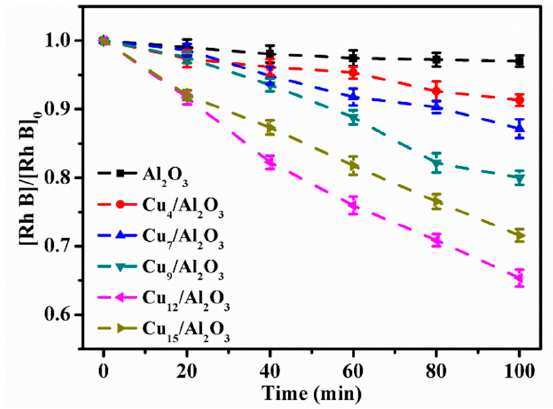
Figure 6. [Rh B] / [Rh B] 0 as a function of time in the presence of 1 g / L Cu x / Al 2 O 3 composite (x = 0, 4, 7, Figure 6. [Rh B]/[Rh B] 0 as a function of time in the presence of 1 g/L Cu x /Al 2 O 3 composite (x = 0, 4, 7, 9, 12, and 15 wt %). Reaction conditions: [Rh B] 0 = 20 mg / L, [H 2 O 2 ] 0 = 10 mM, V = 100 mL, T = 25 ◦ C, 9, 12, and 15 wt %). Reaction conditions: [Rh B] 0 = 20 mg/L, [H 2 O 2 ] 0 = 10 mM, V = 100 mL, T = 25 °C, pH 4.9 pH 4.9 (unadjusted).